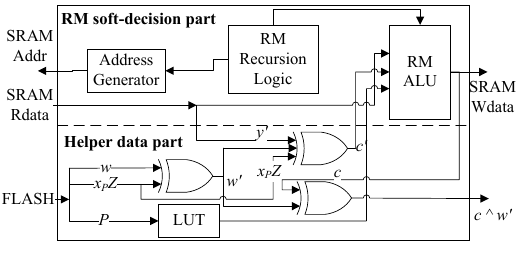
Figure 18. PUF module